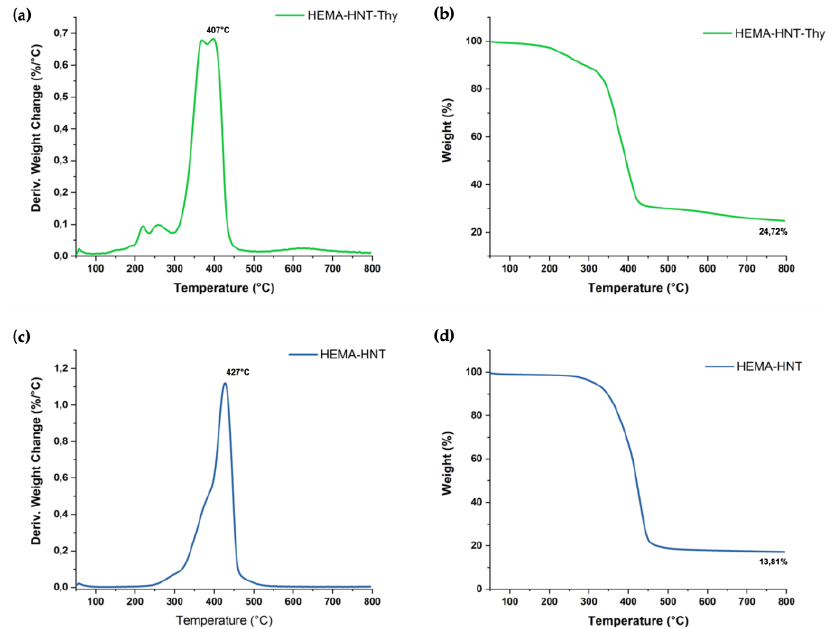
Figure 4. Thermogravimetrical curves TG and DTG of ( a , b ) HEMA-HNT/Thy (green) and ( c , d ) HEMA-HNT (blue).